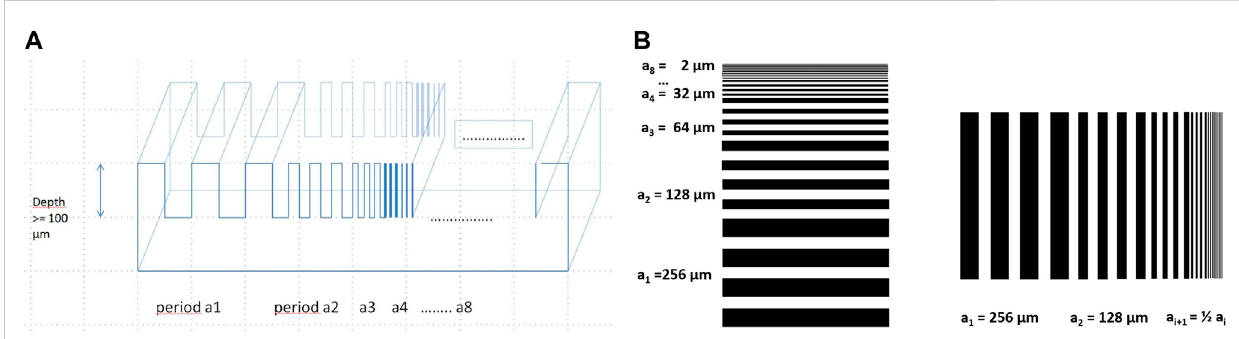
FIGURE 1 (A) (left)DesignproposalforthequalitycontrolinMR-microscopy.Theteststructure(phantom)forthequalitativeandquantitativedetermination of thein-planespatial resolution,shownhereonlyforonedimension,consistsofseveralsetsofperiodicallyarrangedplatewalls(lamellae)characterizedby their spatial distance a i /2 at same lateral width (1µm ≤ a i ≤ 256 µm). The envisaged minimum depth of lamellae is designed to be 100 μ m, thus featuring strong demands on the aspect-ratio of the manufacturing technology. (B) (right) Frontal view of the design for two orthogonal grids, featuring subsequently size-reduced sets of periodically arranged plates with a i+1 = ½ a i . The periodic length a i is proposed to start at a 1 = 256 µm and may range down to a 8 = 2 µm. Intermediate steps in DXR-Lithography realization are possible. The two orthogonal arrangements allow for independent analysis of two different spatial directions, e.g., phase (spin warp) and frequency spatial